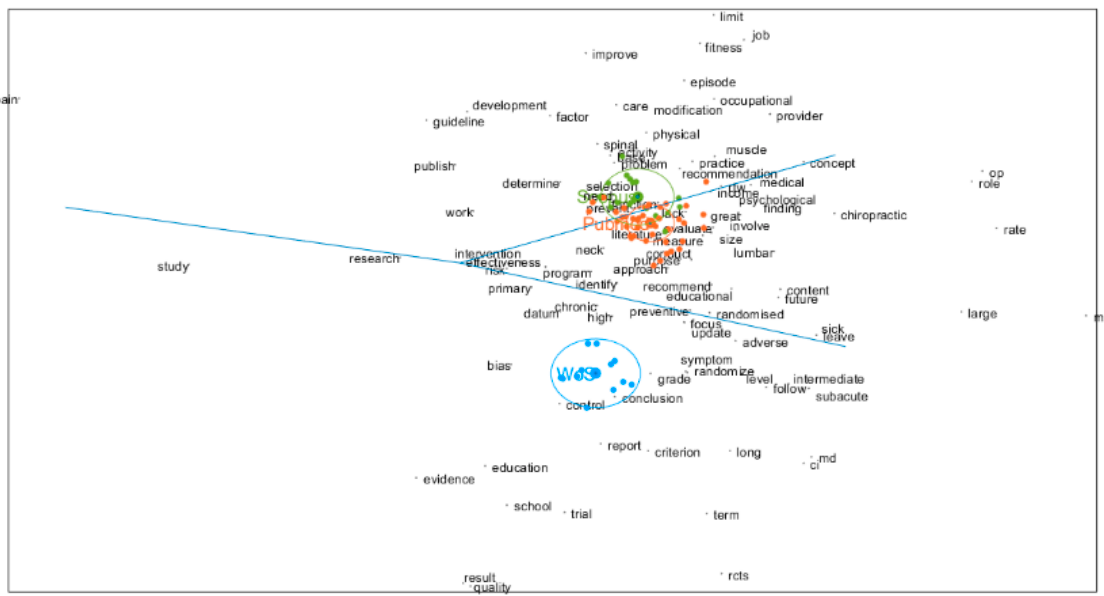
Figure 14. SRL in health sciences (low back pain prevention) using MANOVA Biplot.